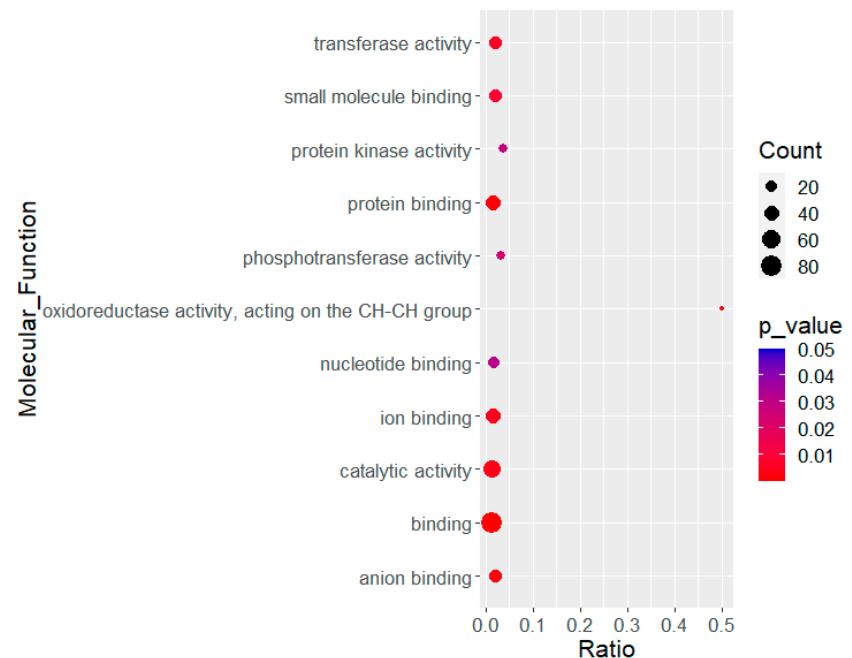
Figure 2. Gene Set Enrichment Analysis (GSEA) of molecular functions for the commonly upregulated transcripts in Aag2 cells treated with hC3 and hC5a and compared against untreated control cells.